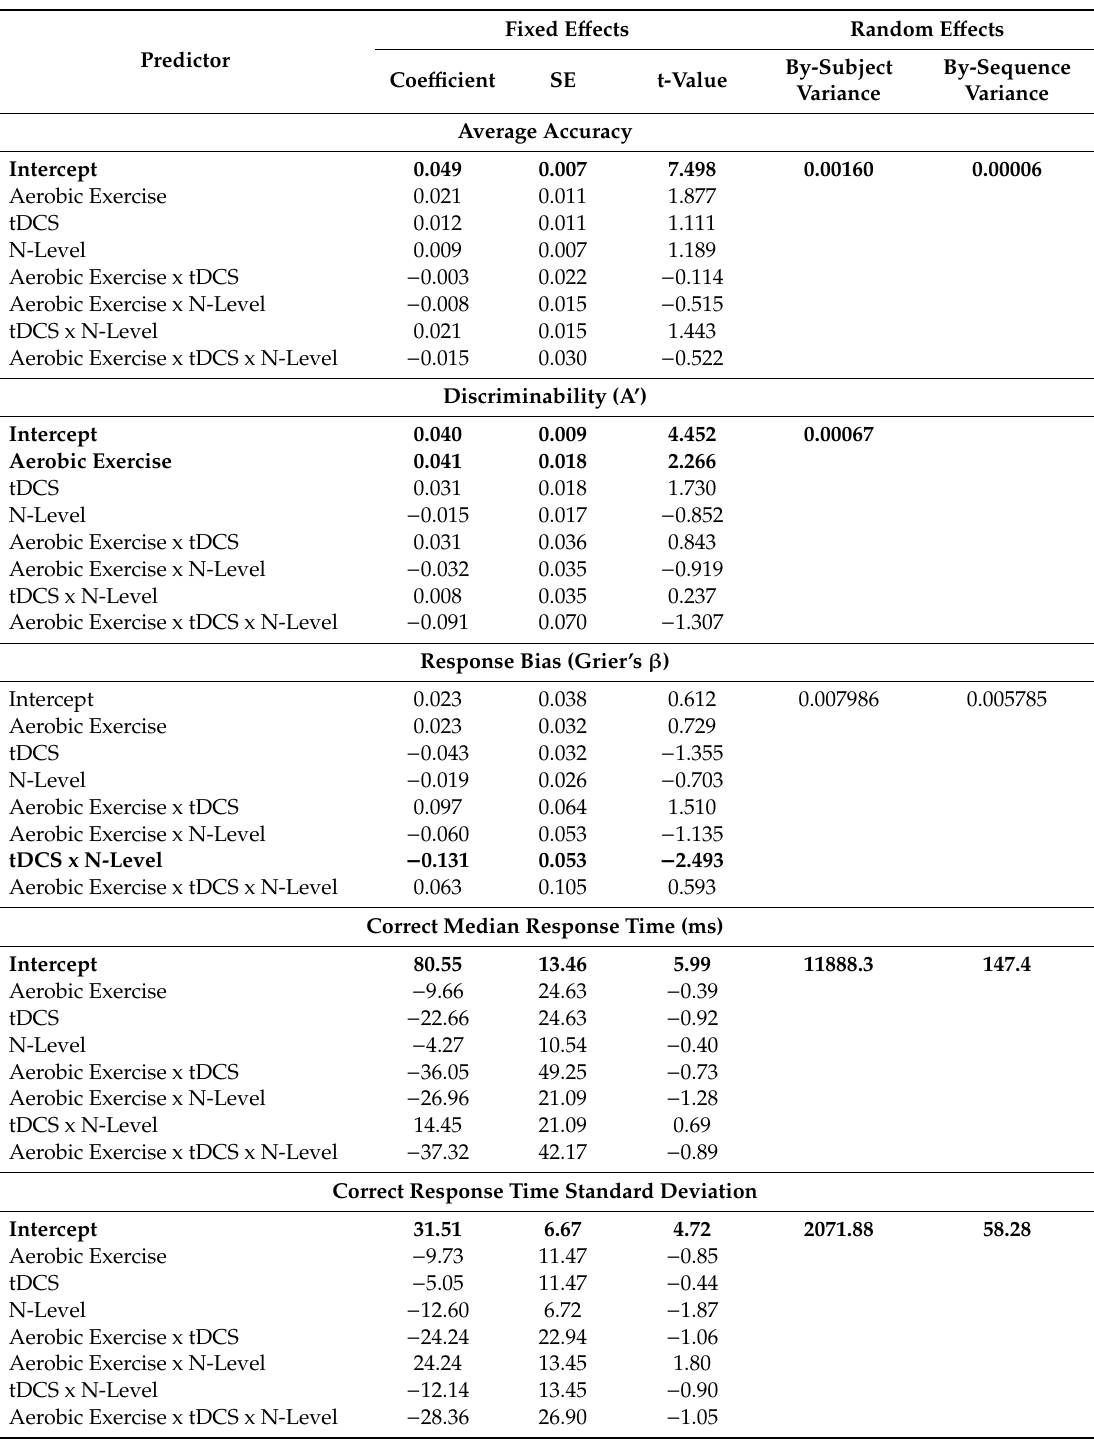
Table 3. Linear mixed-e ff ect model output of Aerobic Exercise (Seated vs. Exercise), tDCS (Active vs. Sham), and Congruency (Incongruent vs. Congruent) on the n-back task for accuracy, A’, Grier’s β , median correct response time, correct response time standard deviation, and ex-Gaussian parameters ( µ , σ , and τ ). Bolded model parameters indicate significant findings (i.e., t > | 2.00 | ). SE = Standard Error. Split across two panels is N-Level (2-Back vs. 4-Back, on the left and right, respectively). Error bars reflect standard errors of the